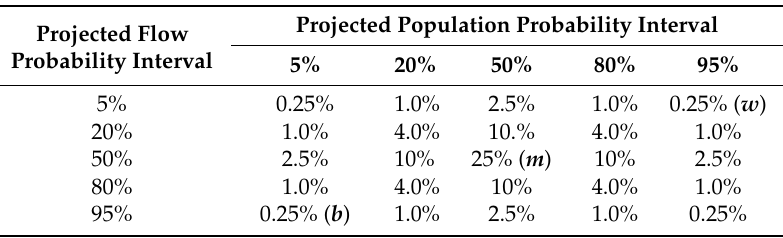
Table 3. Scenarios to be assessed for each time period, with their percentage likelihoods.